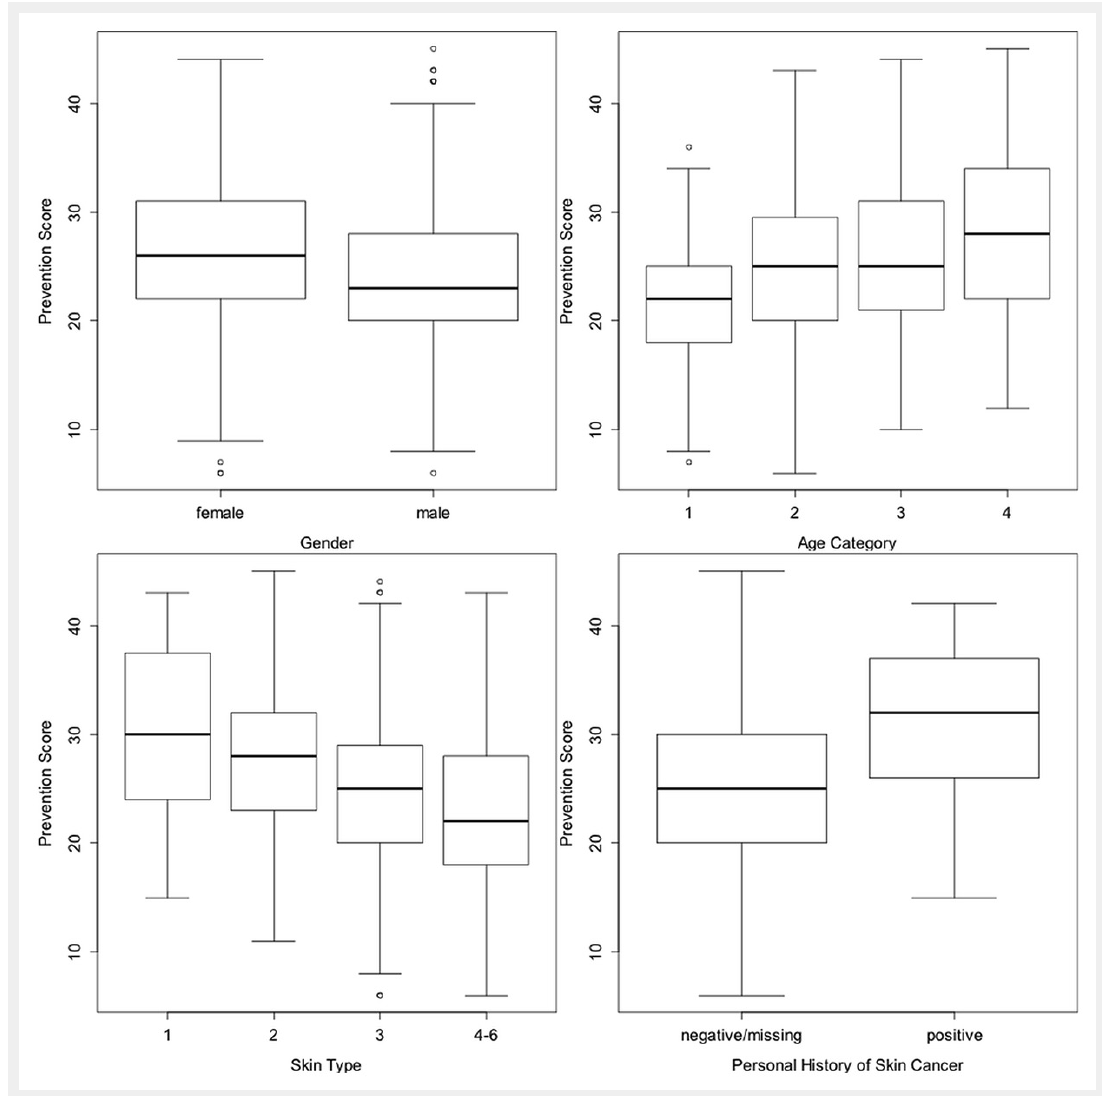
Figure 2 Box plots of the ultraviolet radiation prevention score and gender, age category, skin type and personal history of skin cancer of the participants, univariate level. The correlation between the UVR prevention score and gender, age category, skin type, and personal history of skin cancer were statistically significant (for individual p-values refer to table 2). Four age categories were made, based on the year of birth of the athletes: Category 1 (18–24 years), category 2 (25–34 years), category 3 (35–54 years) and category 4 (≥55 years). The skin type was divided into four different groups: category 1 (Fitzpatrick skin type I), category 2 (Fitzpatrick skin type II), category 3 (Fitzpatrick skin type III) and category 4 (Fitzpatrick skin type